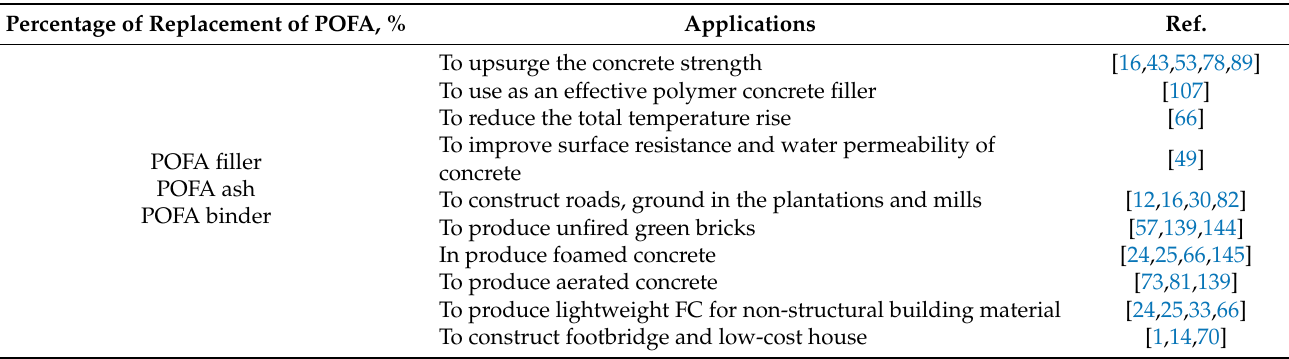
Figure 14. Global palm oil production, 2016/2017 [143]. Reprinted with permission from Karayannis et al. [143]. Table 12. Applications of